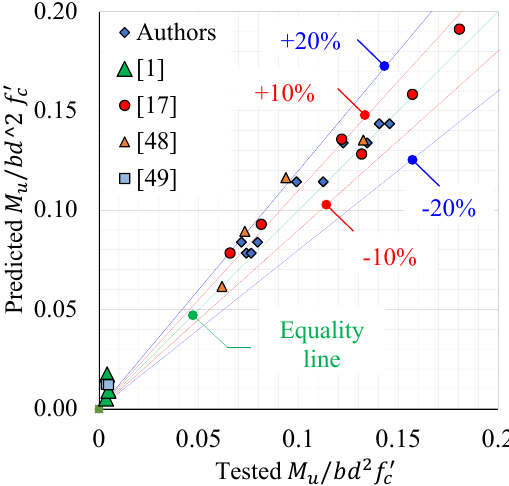
Figure 14. Predicted vs. observed M u / bd 2 f (cid:48) c [1,17,48,49]. Figure 14 indicates that the majority of the predicted 𝑀 (cid:3048) /(𝑏𝑑 (cid:2870) 𝑓 (cid:3030)(cid:4593) ) values using Equation (6) were close to the line of equality (LOE (prediction = test results)). However, few data points were underneath the LOE, while the majority of the data points were